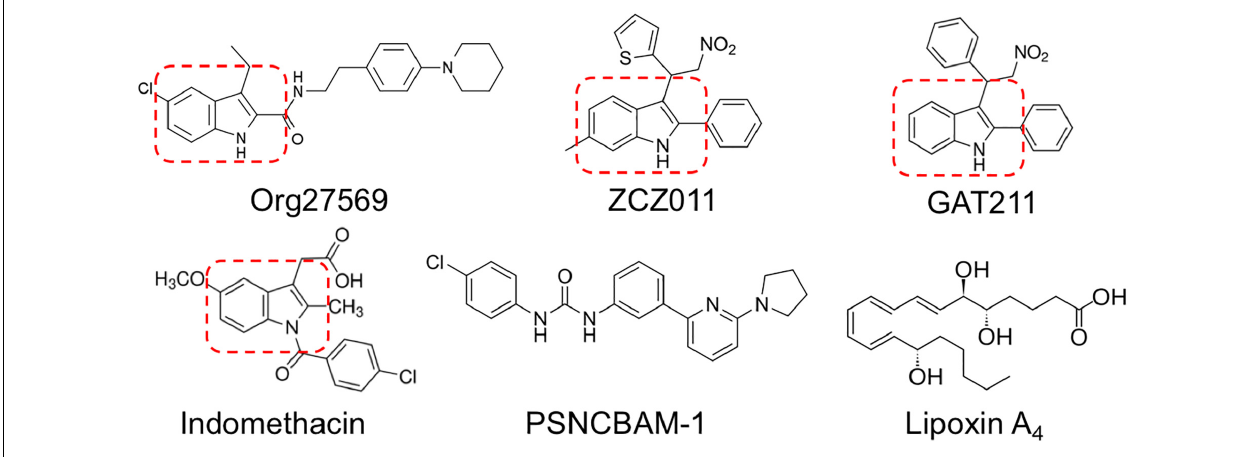
FIGURE 1 | Previously described allosteric modulators of